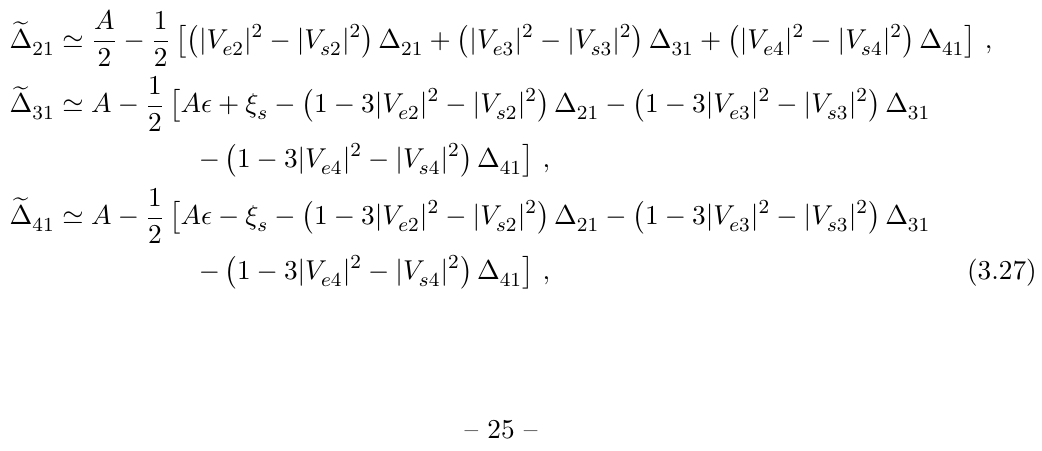
Figure 11 . In the (3 + 1) mixing scheme, the illustration of how 1 ; 2 ; 3 ; 4) evolve with the matter e(cid:11)ect parameter A in the case (NMO ; (cid:23) radiative corrections, where we typically take the best-(cid:12)t values of ( (cid:18) and for the active-sterile neutrino mixing part ( (cid:18) (cid:1) = 1 : 32 eV 2 41